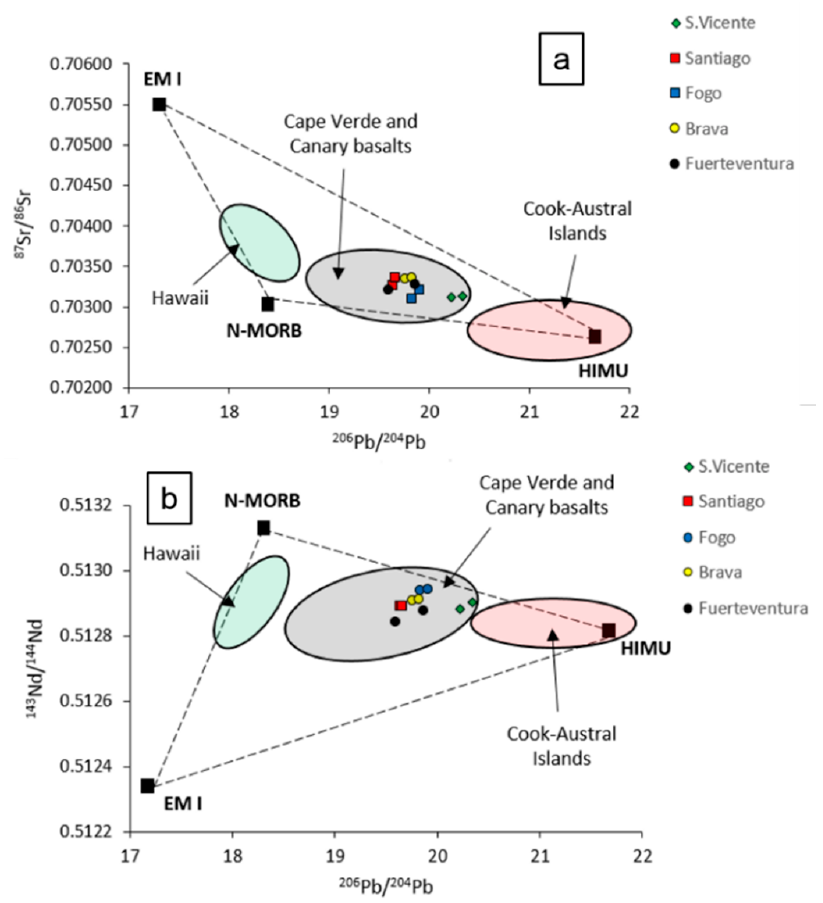
Figure 7. ( a ) 87 Sr/ 86 Sr vs. 206 Pb/ 204 Pb and ( b ) 143 Nd/ 144 Nd vs. 206 Pb/ 204 Pb initial ratios of Fuerteventura and Cape Verde carbonatites (data from De Ignacio et al. 2006 and Hoernle et al. 2002, respectively [20,21]). Mantle components after Hart (1988) [98]. Also shown for comparison are the following: (1) Canary and Cape Verde basalts [99,100]; (2) Hawaii [101–103] and Cook–Austral Islands volcanic rocks [95].